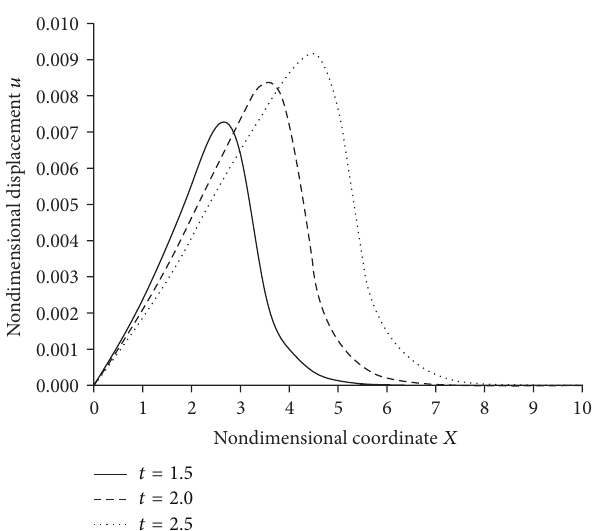
Figure 3: Nondimensional displacement distribution for different 𝑡 values.